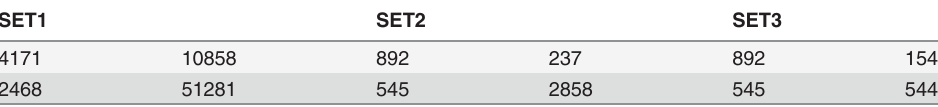
Table 7. Confusion matrices for the C4.5 algorithm. SET1 SET2 SET3 10858